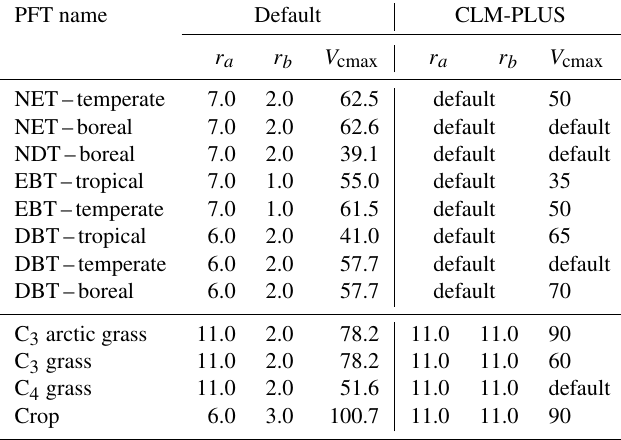
Table A1. The PFT-specific values of V cmax (µmolm − 2 s − 1), r a , and r b in the default of CLM4.5 and in CLM-PLUS.